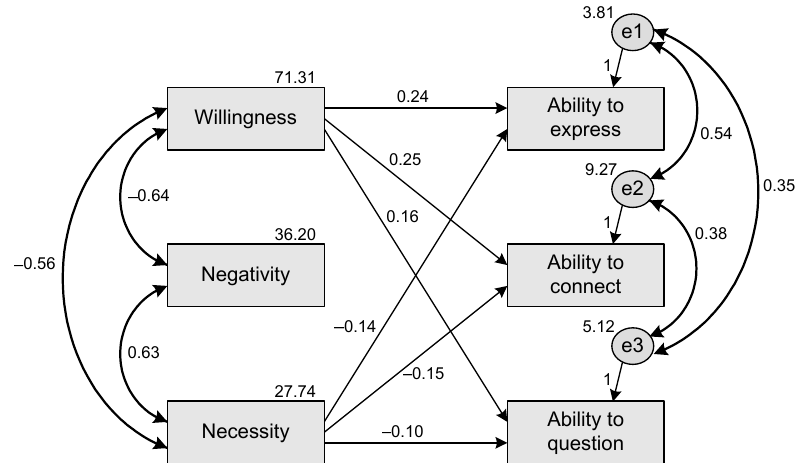
Figure 1. The SEM of CPLA to CT perspectives.